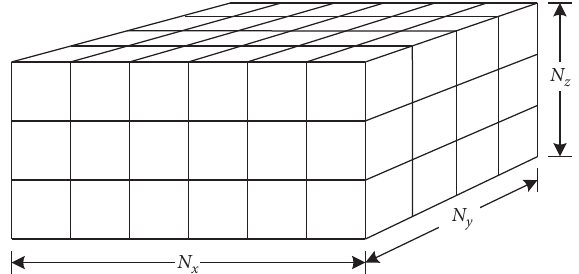
Figure 4: An example of finite element mesh.